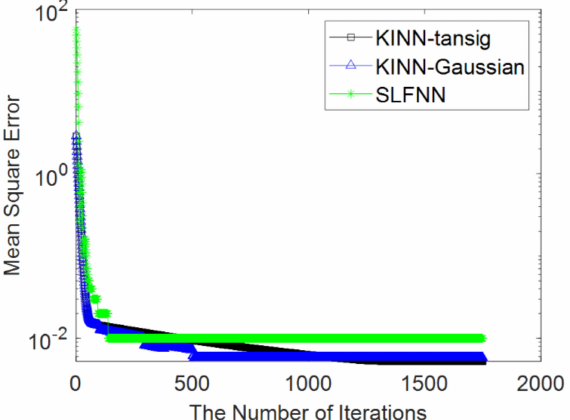
Figure 11. The training error (MSE) curves of KINN-tansig, KINN-Gaussian and SLFNN for the braided river reservoir case. The black line with squares is the error curve of KINN-tansig; the blue line with triangles represents the error curve of KINN-Gaussian; and the green line with stars represent the error curve of SLFNN.